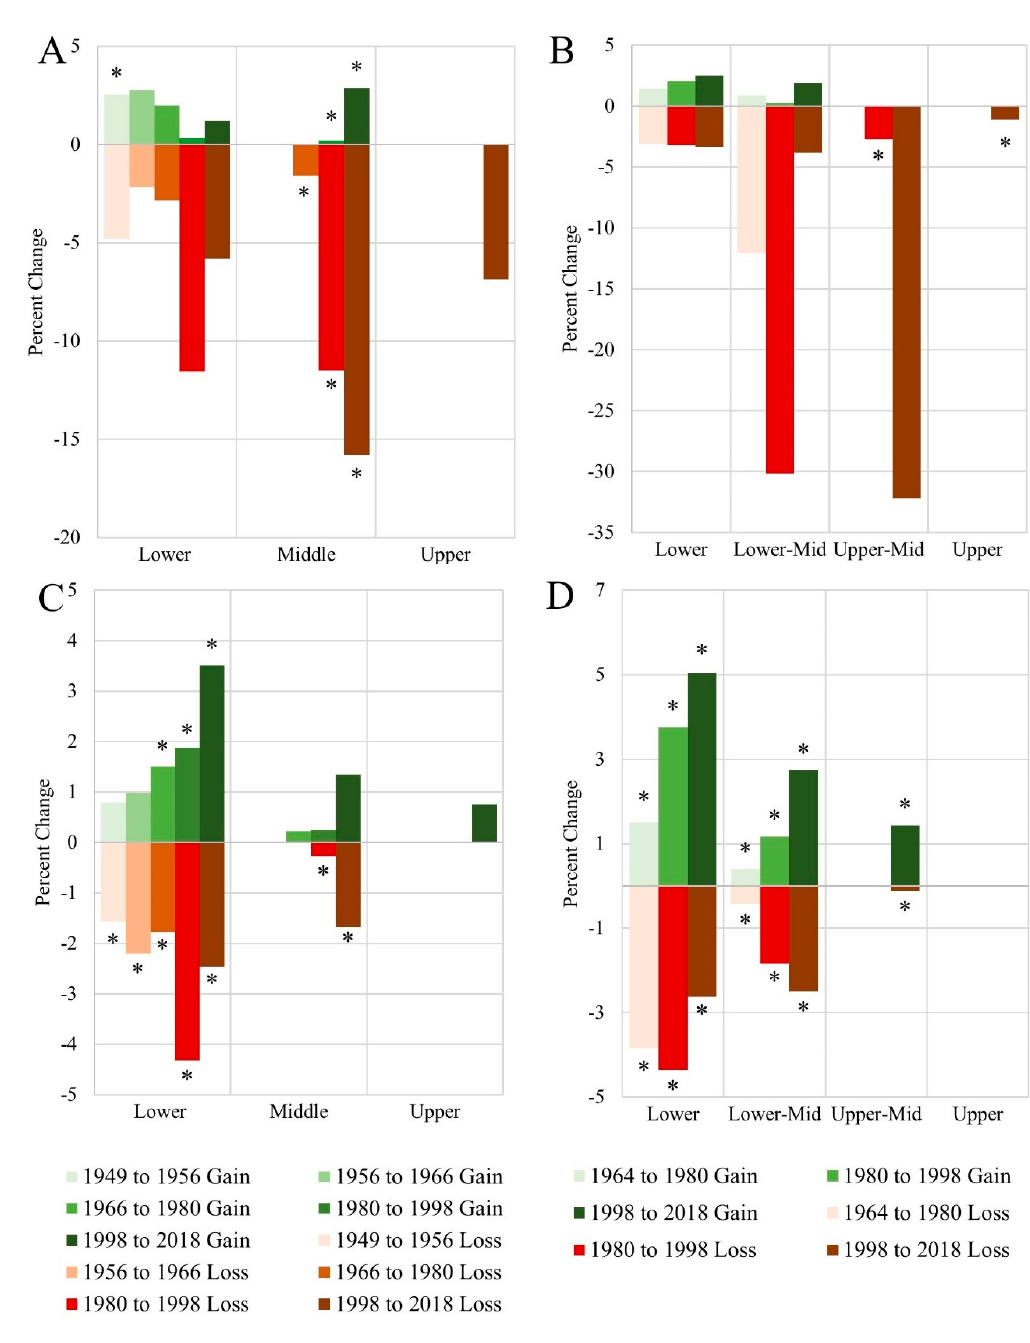
Figure 7. Land cover change (in percent) between forest and emergent wetland ( A and B ) and wetland and water ( C , D) for Smith Creek ( A , C ) and Town Creek ( B , D ). Transitions indicated with “*” emergent wetland and water ( C and D) for Smith Creek ( A and C ) and Town Creek ( B and D ). were significantly more than Transitions indicated with “*” were significantly more than expected.